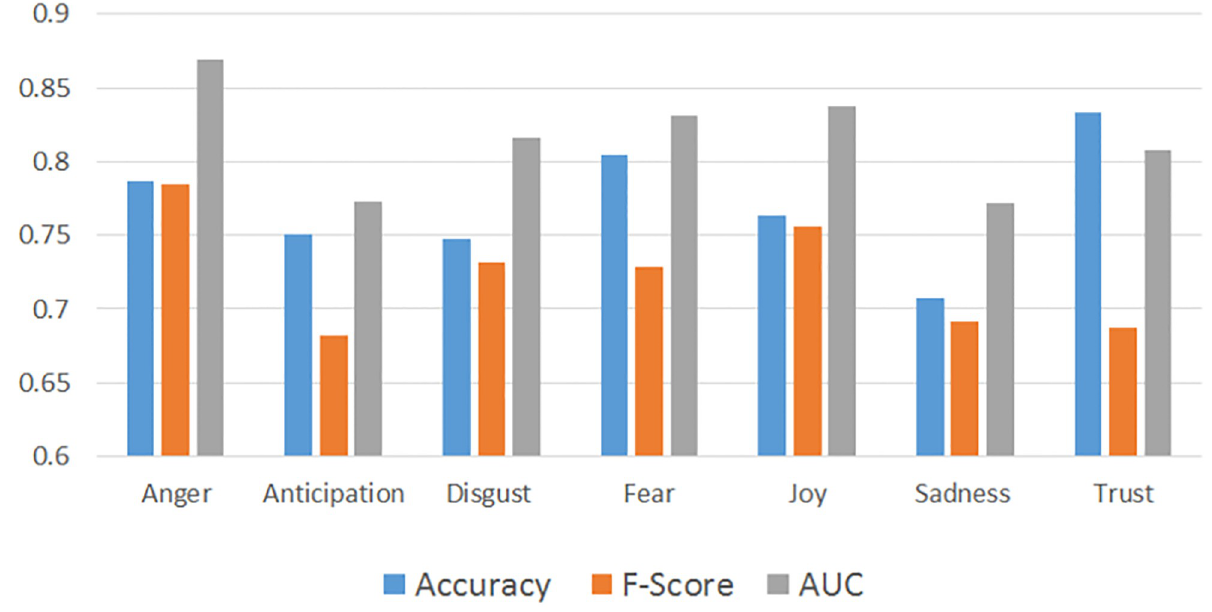
Fig 2. Performance metrics for the models used in the study (10-fold cross